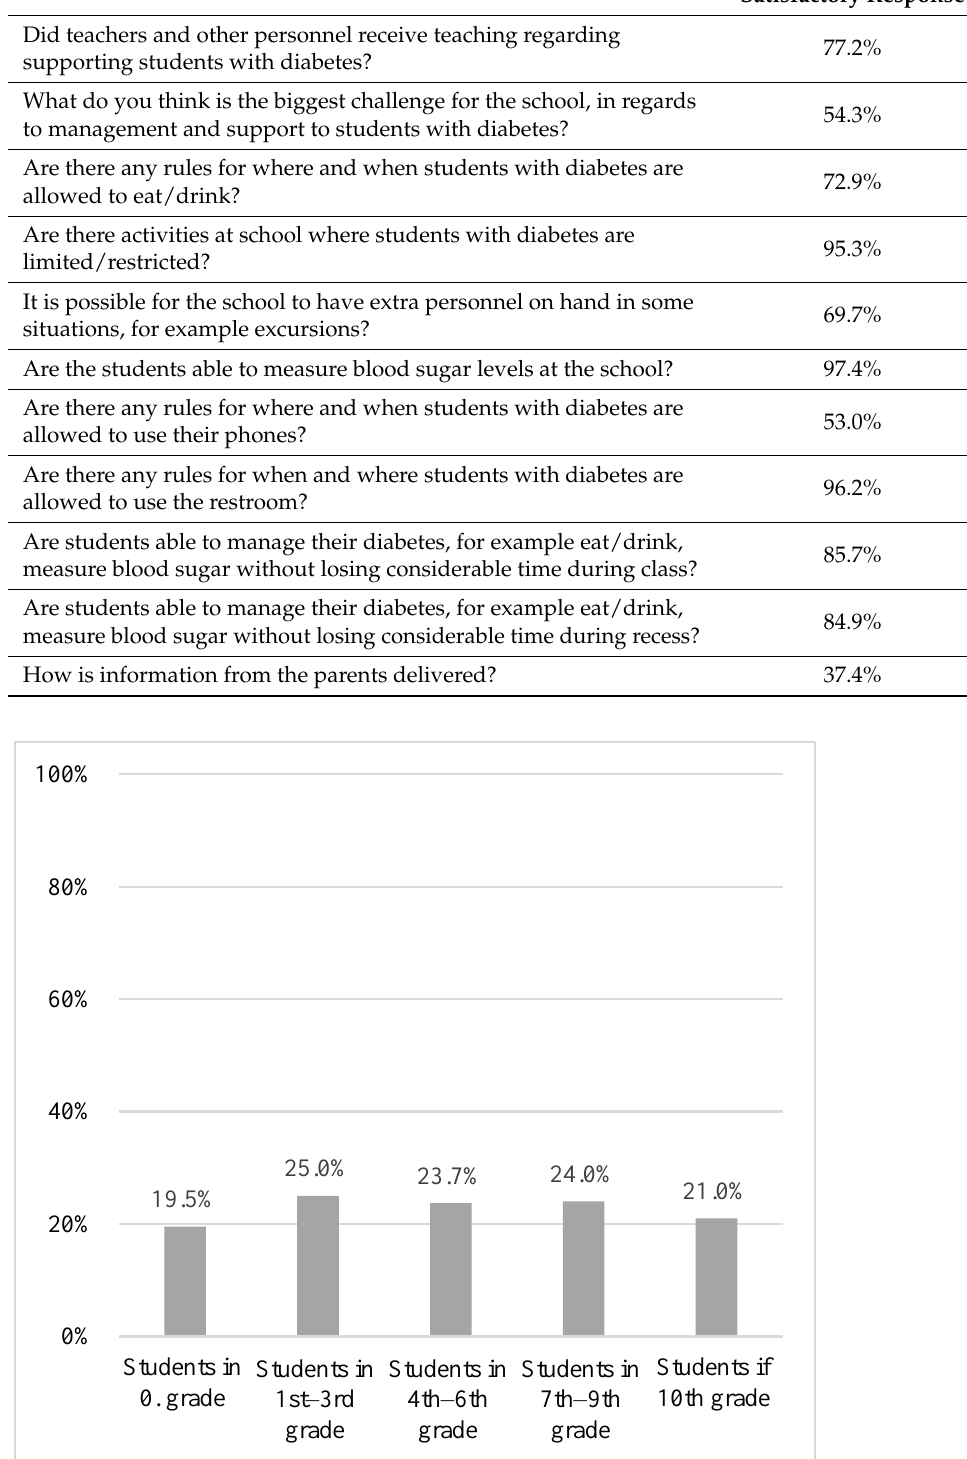
Figure 2. Proportion of schools allocating extra hours to students with diabetes, stratified by grade.